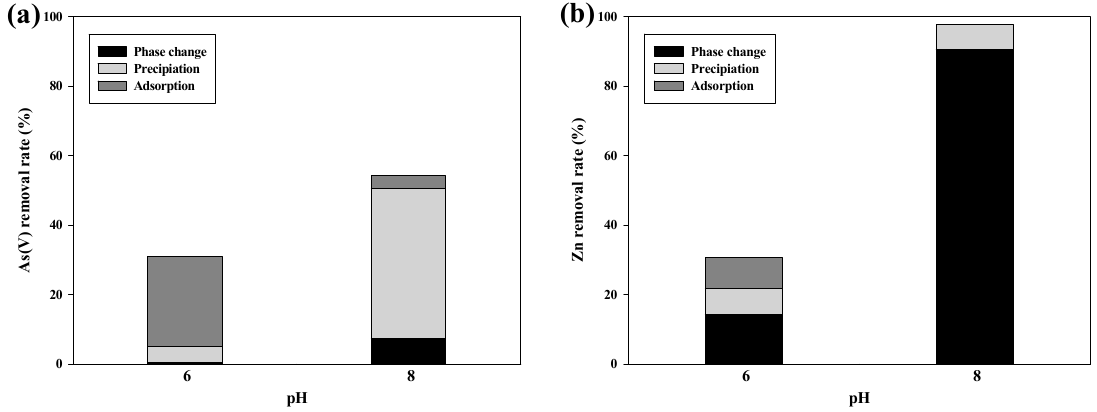
Figure 3. Fractions of ( a ) As(V) and ( b ) Zn(II) removal from the As + Zn + Kaolin solution according to solution pH. Table 1. Saturation index of As and Zn calculated via Visual MINTEQ 3.1 according to solution pH.